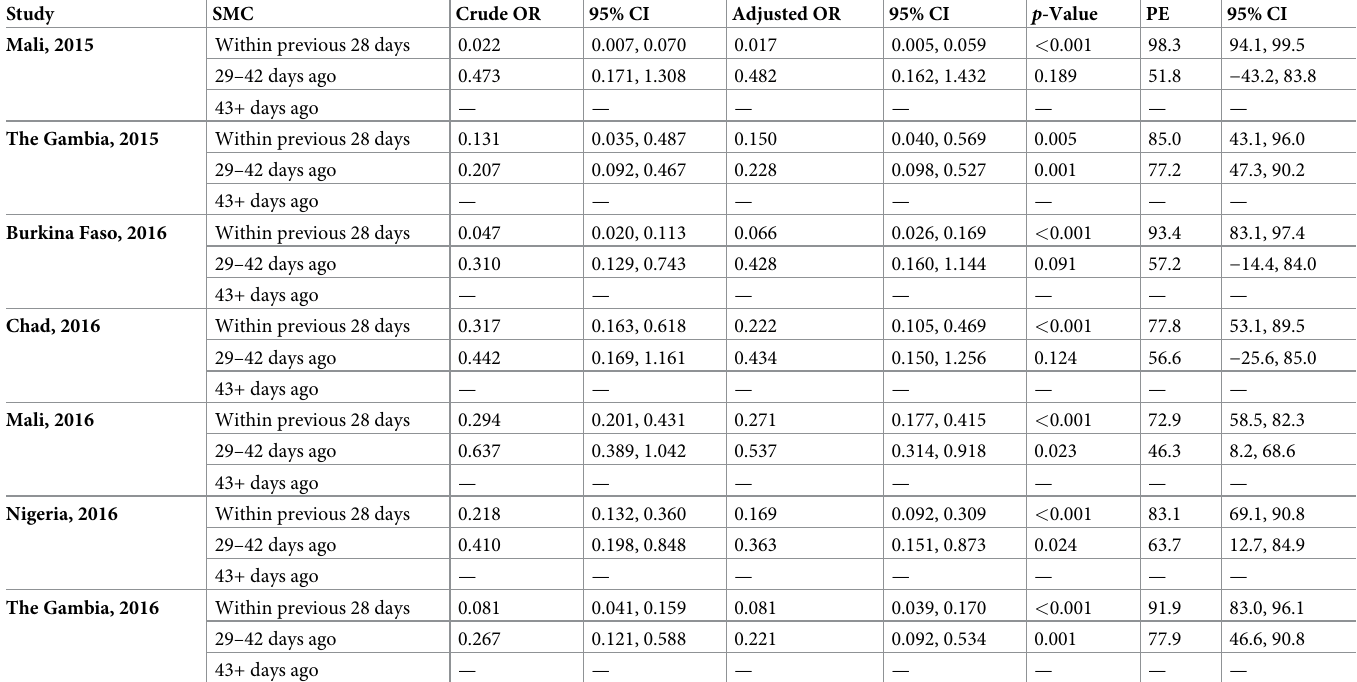
Table 2. Association of SMC with clinical malaria in individual